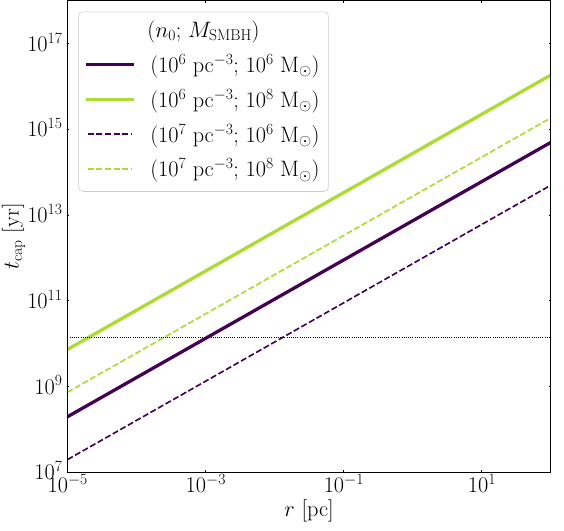
Figure 7. Timescale for gravitational wave capture assuming a black hole mass m BH = 15 M function of the distance from the SMBH and for different values of the SMBH mass and BH number density. 4/7 ; thus, these binaries are characterised by ( σ /100km s − 1 ) r p (cid:46) 7.4 10 − 3 R − × (cid:12)